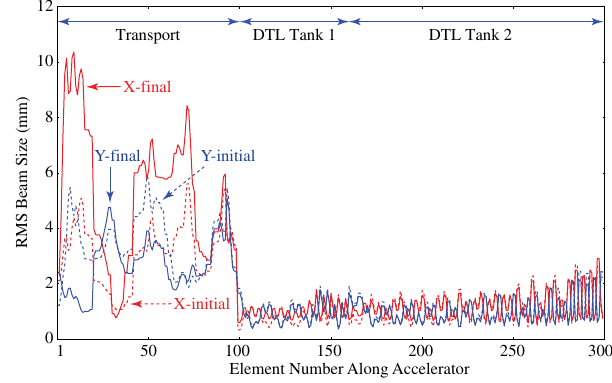
FIG. 15. Evolution of the magnet gradients before, during, and after variation of beam and phase delay parameters.